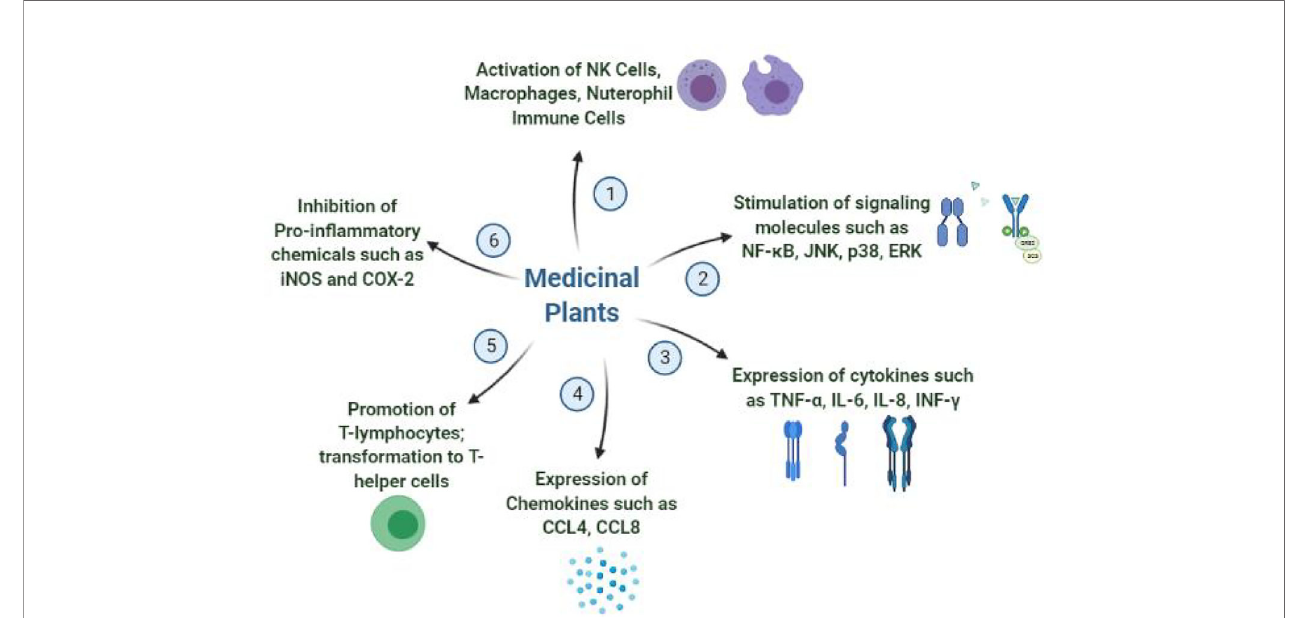
FIGURE 3 | General immunomodulation mechanisms shown by medicinal